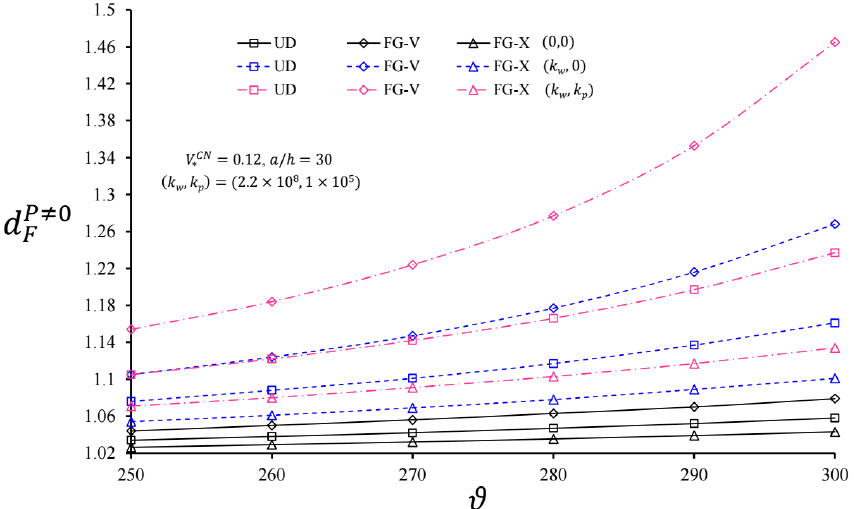
≠ P d for infinite length CNT-based cylindrical pipes with and without EFs versus ϑ for CN Figure 5. Variation in 0 Figure 5. Variation in d P (cid:54) = 0 for infinite length CNT-based cylindrical pipes with and without EFs F F = 0.12 and = 30 a h . versus ϑ for V CN ∗ = 0.12 and a = 30